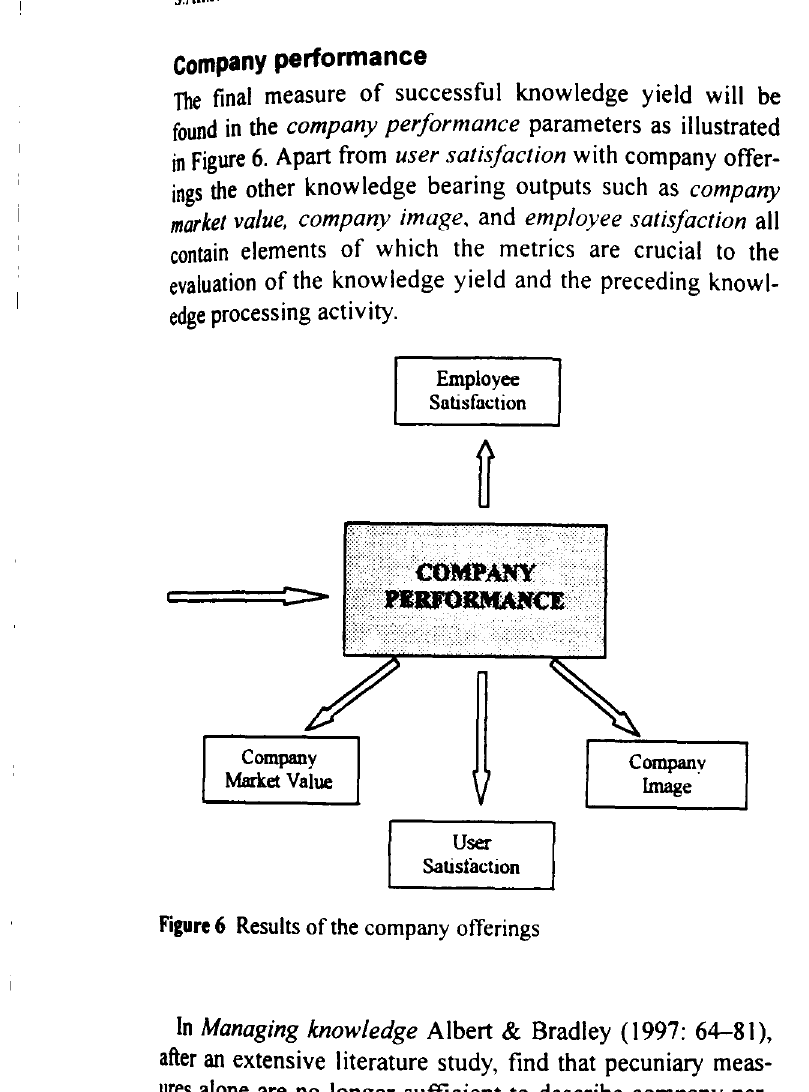
Figure 6 Results of the company offerings